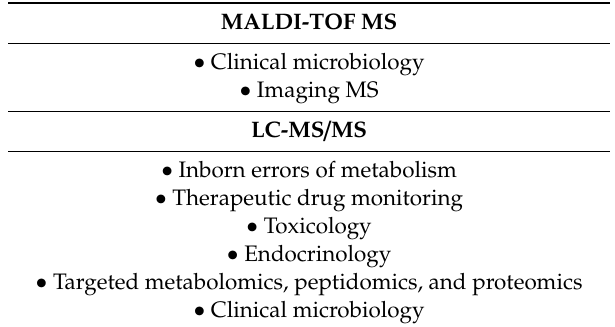
Table 1. Applications of MALDI-TOF MS and LC-MS / MS in laboratory